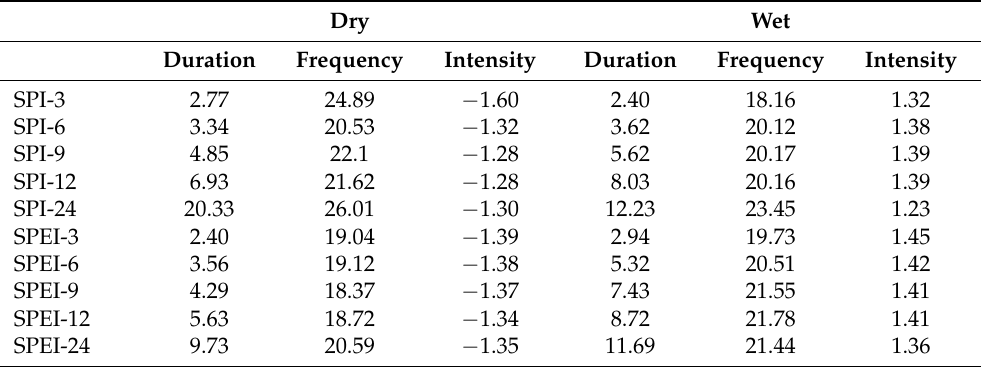
Table 3. Characterization (duration, frequency, and intensity) of dry and wet events at Djibouti Airport station over the period 1961–2021.